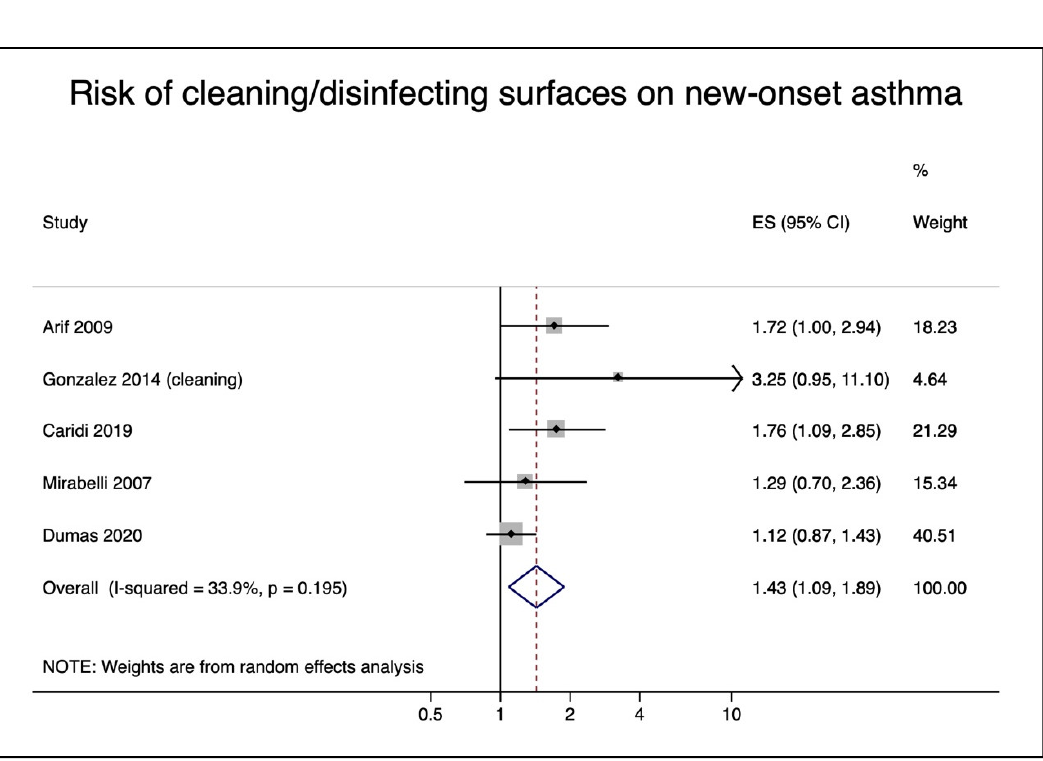
Figure 4. Pooled risk of cleaning/disinfecting surfaces on new-onset asthma in nurses.